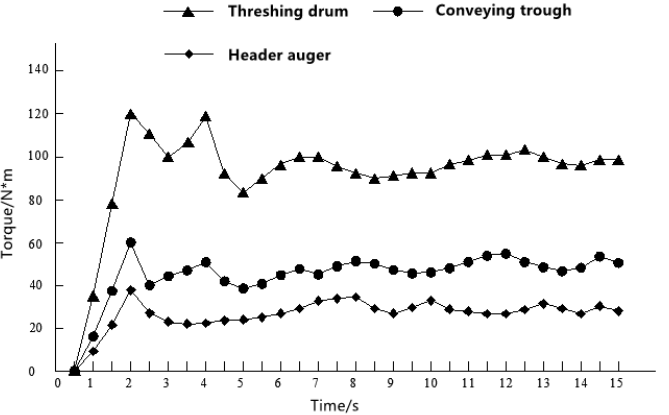
Figure 14. The relationship curve of torque and time of the threshing drum, conveying trough and cutting table screw conveyer.